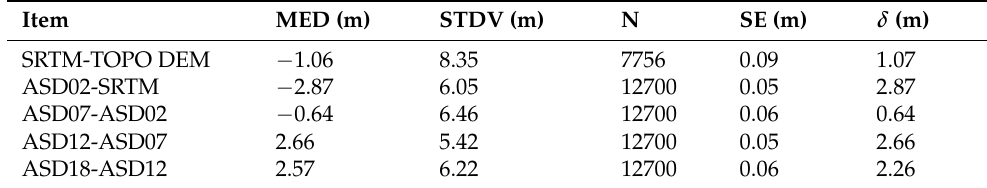
Table 2. Statistics of vertical errors between the TOPO, SRTM, and ASTER DEM. MED is mean elevation difference, STDV = standard deviation, N = number of considered pixels, SE = standard error, and δ = the overall error of the derived surface elevation